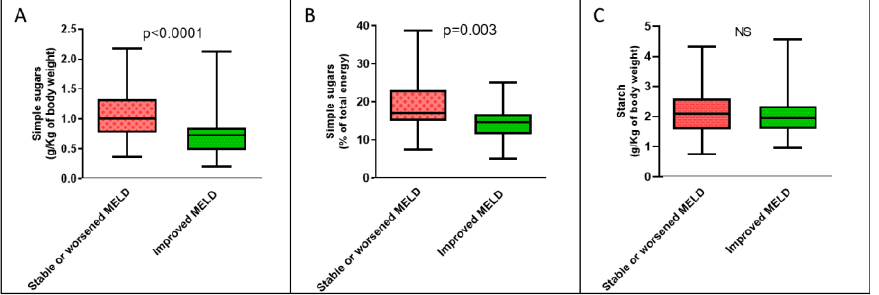
Figure 2. Boxplots of the amount of dietary carbohydrates consumed each day according to temporal changes in MELD score by all cirrhotic patients. ( A ) Intake of simple sugars expressed in g/Kg of body weight; ( B ) intake of simple sugars expressed as a percentage of total energy; ( C ) intake of starch. NS: not significant.